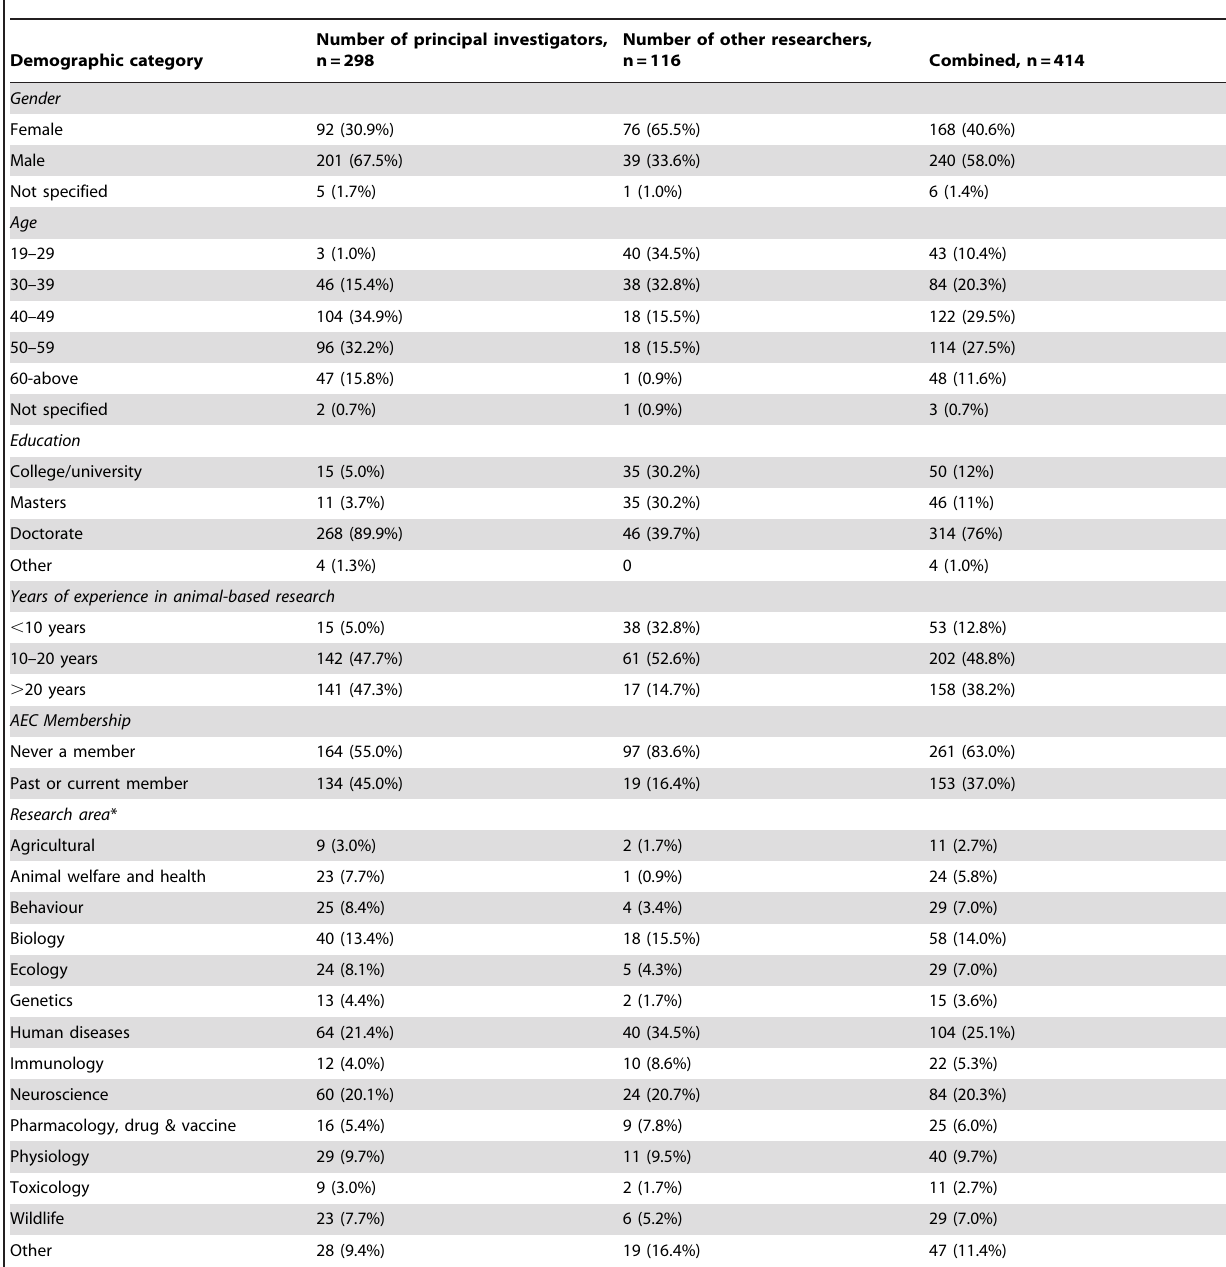
Table 2. Demographic information on survey participants: principal investigators (n=298), other researchers (n=116) and combined